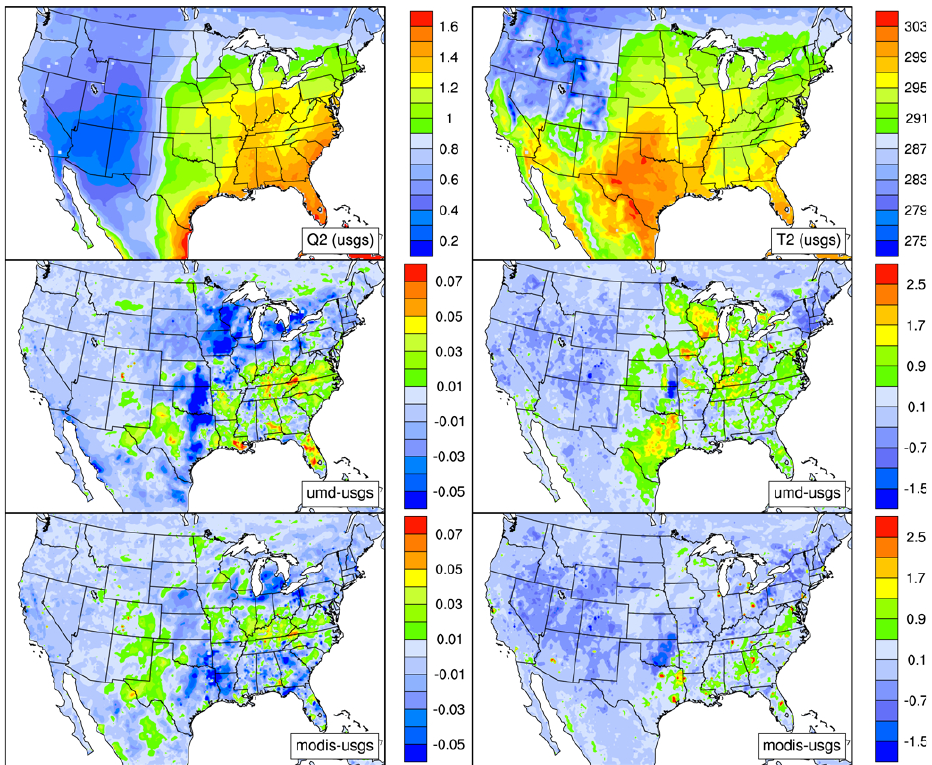
Fig. 5. Same as Fig. 3 except for average water vapor content ( Q 2, %, left panels) and air temperature ( T 2, K, right panels) at 2m.